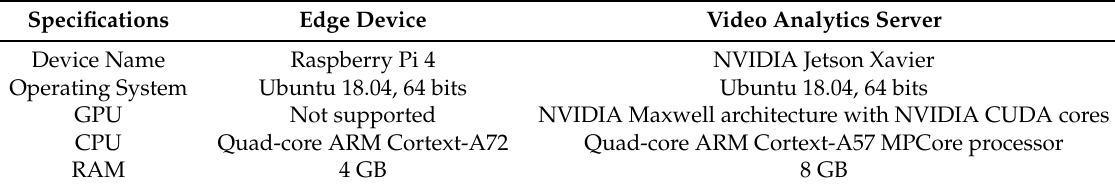
Figure 12. Testbed: ( a ) scenario setup, ( b ) the implemented edge device. Table 1. Hardware specifications.